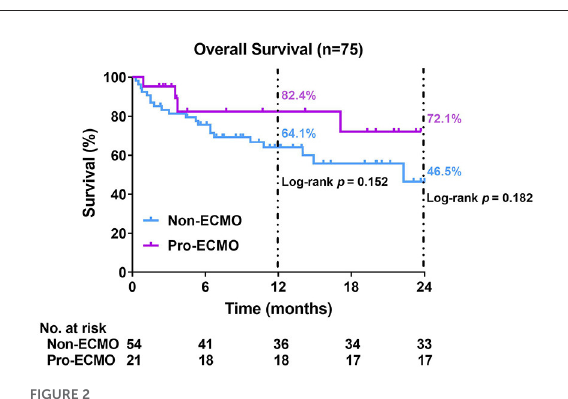
FIGURE2 Kaplan–Meier curves for overall survival. Differences between the two curves were identified using the log-rank test. ECMO, extracorporeal membrane